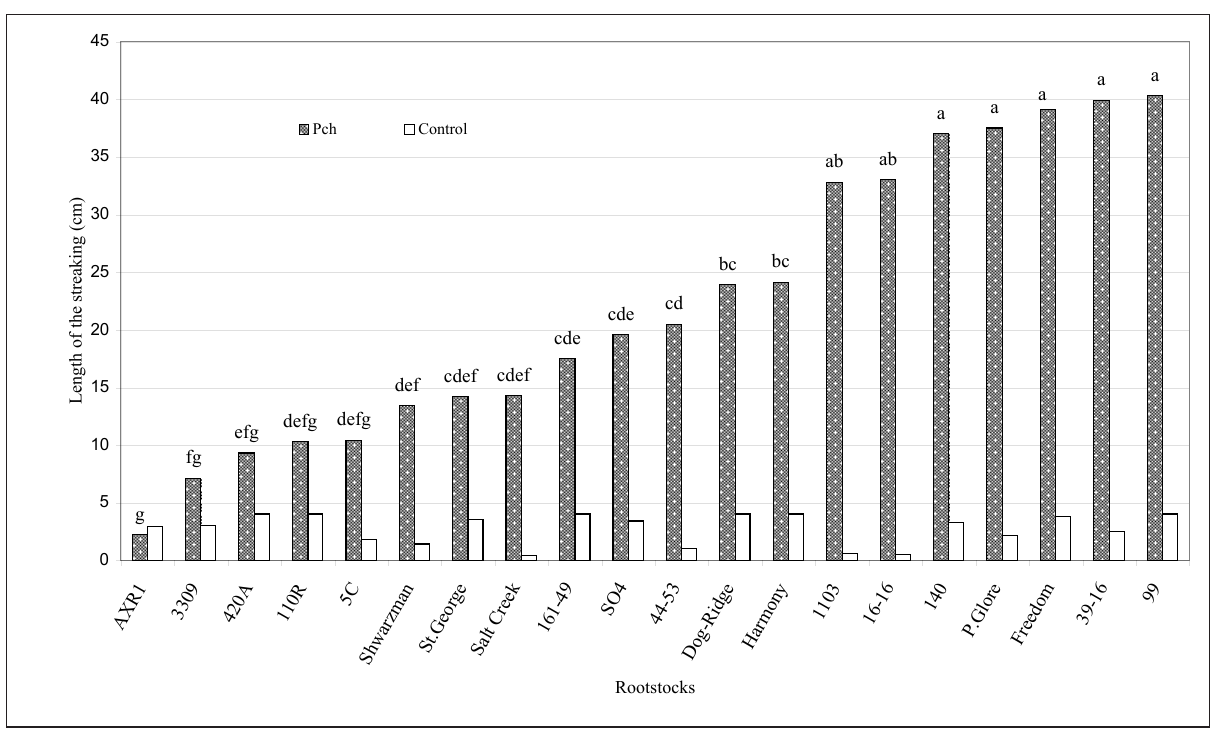
Fig. 2. Length of vascular streaking (cm) in Phaeomoniella chlamydospora (Pch) inoculated